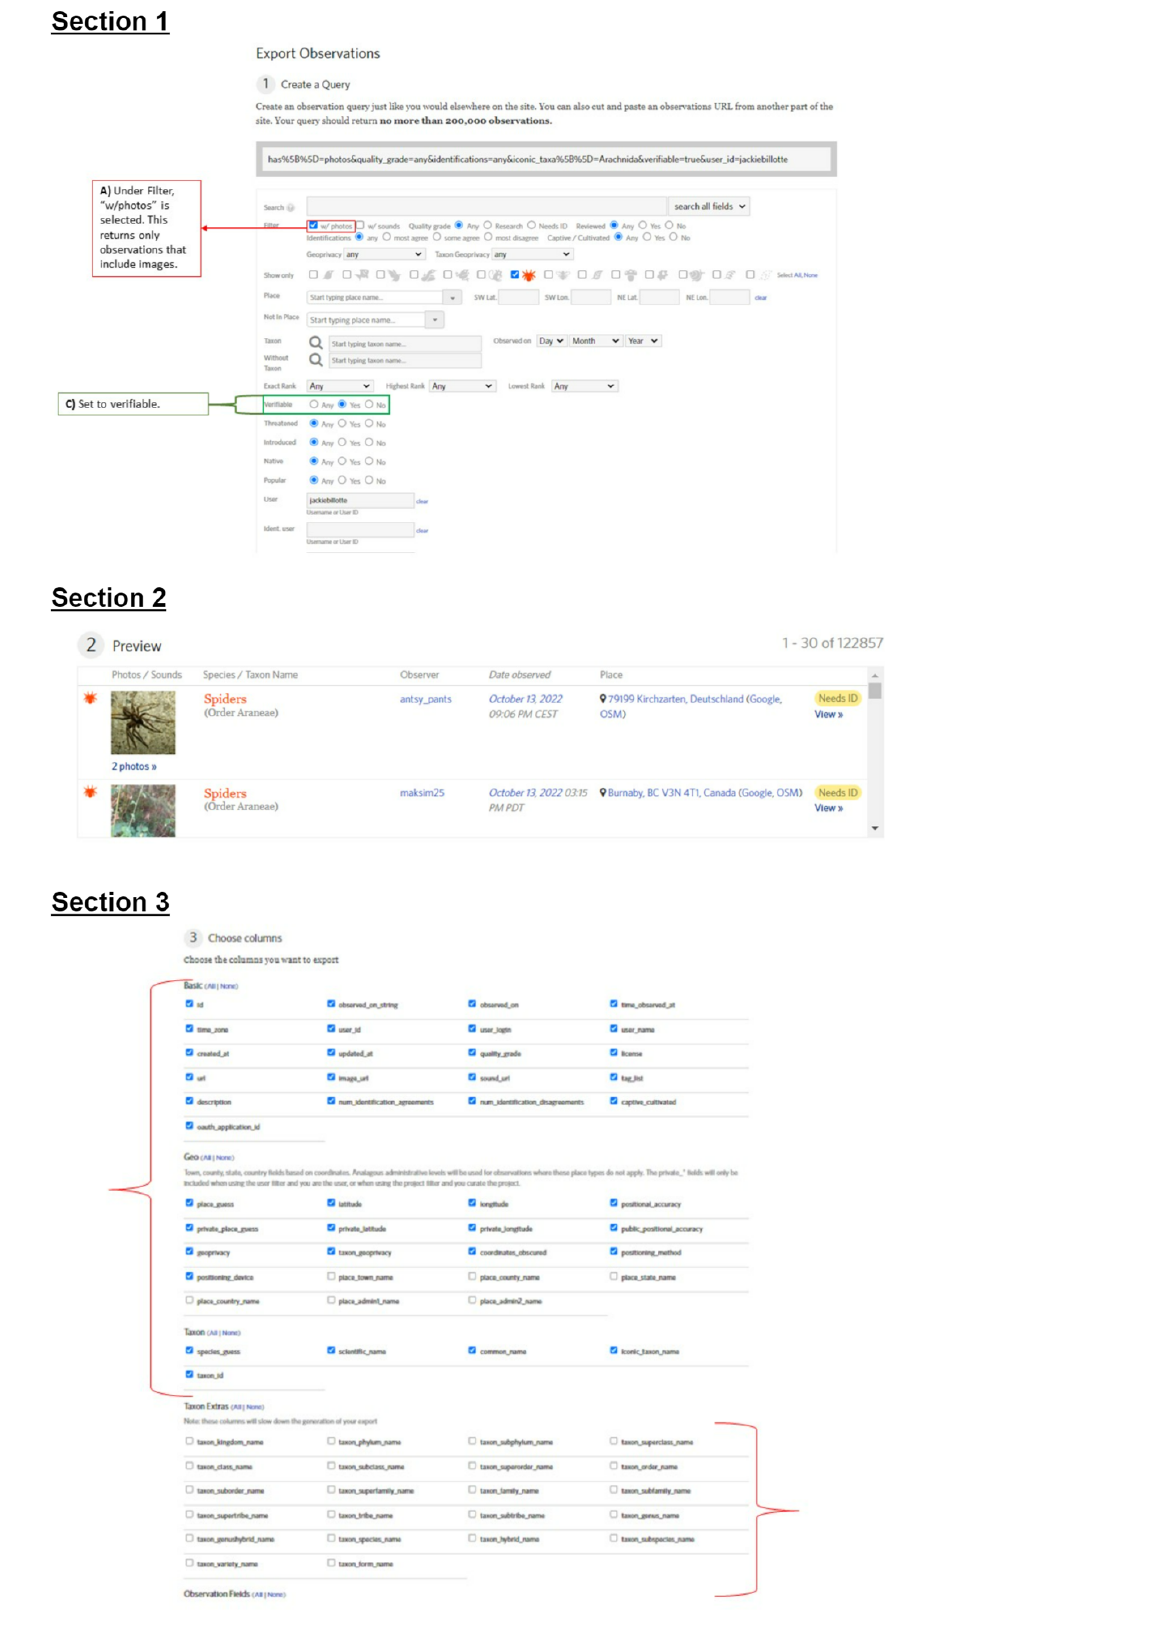
Figure 2. Option selections for downloading query results using the downloading function in iNaturalist. Part A) is the selection for Section 1. B) shows the selections for Section 3. No changes are made to the default settings in Section